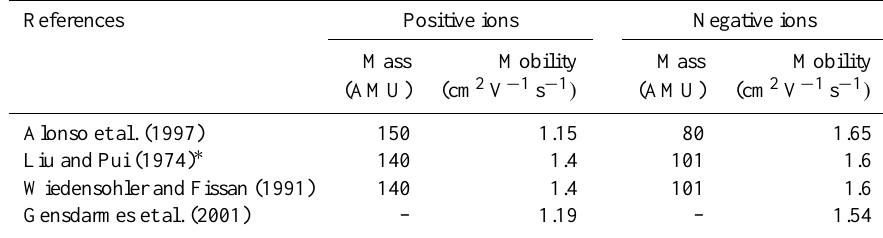
Table 1. Properties of ions used for experimental observations.